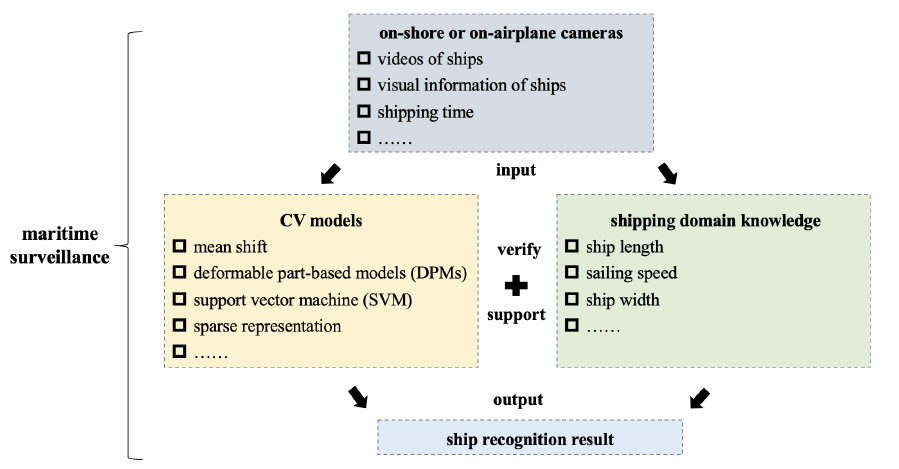
Figure 1. The decision framework of integrating shipping domain knowledge into CV models for ship